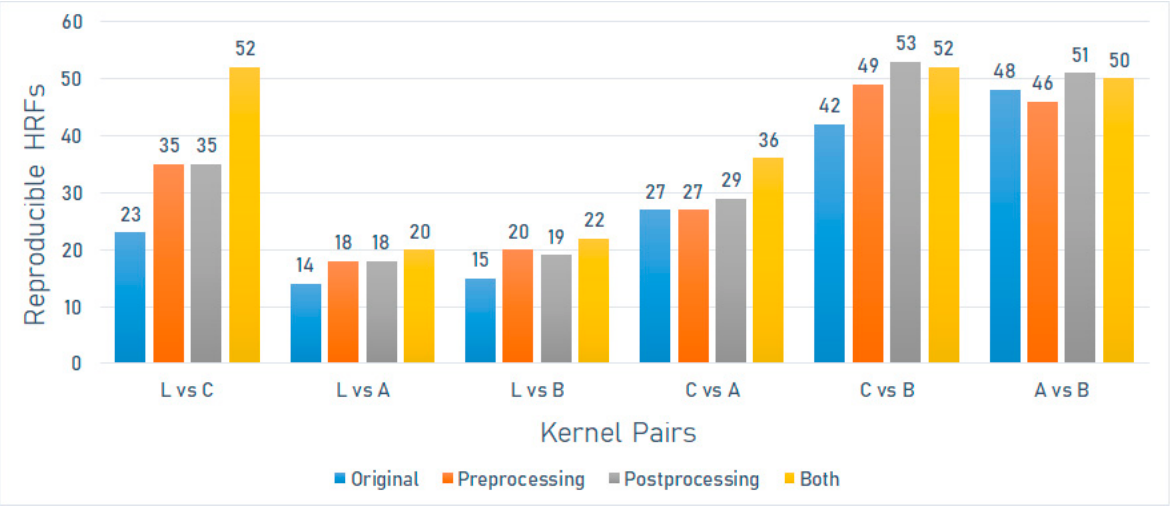
Figure 6. The number of reproducible HRFs across different kernels on the Brilliance 64 scanner model.